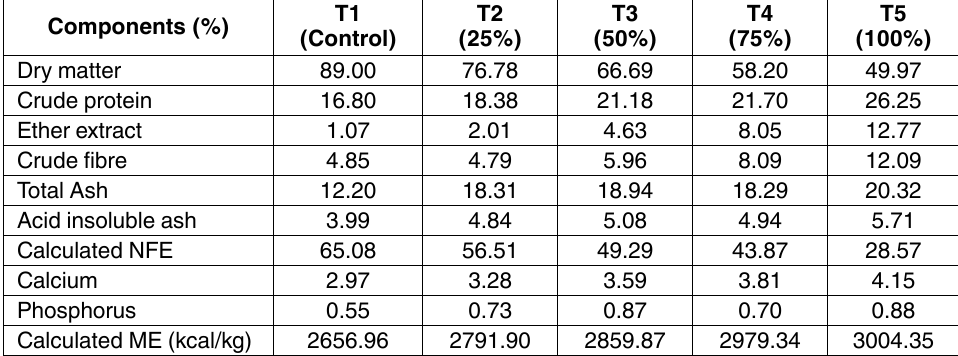
Table 2. Chemical composition of experimental diets